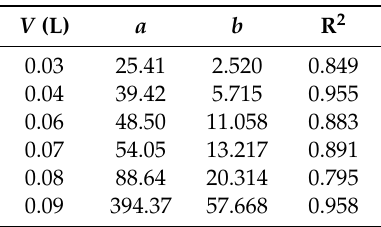
Table 6. Parameters a and b of the scaling laws n e = n e ( R ) for each injection volume considered and the relative values of R 2